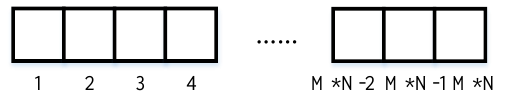
Figure 2. Two-dimensional topological line arrangement.